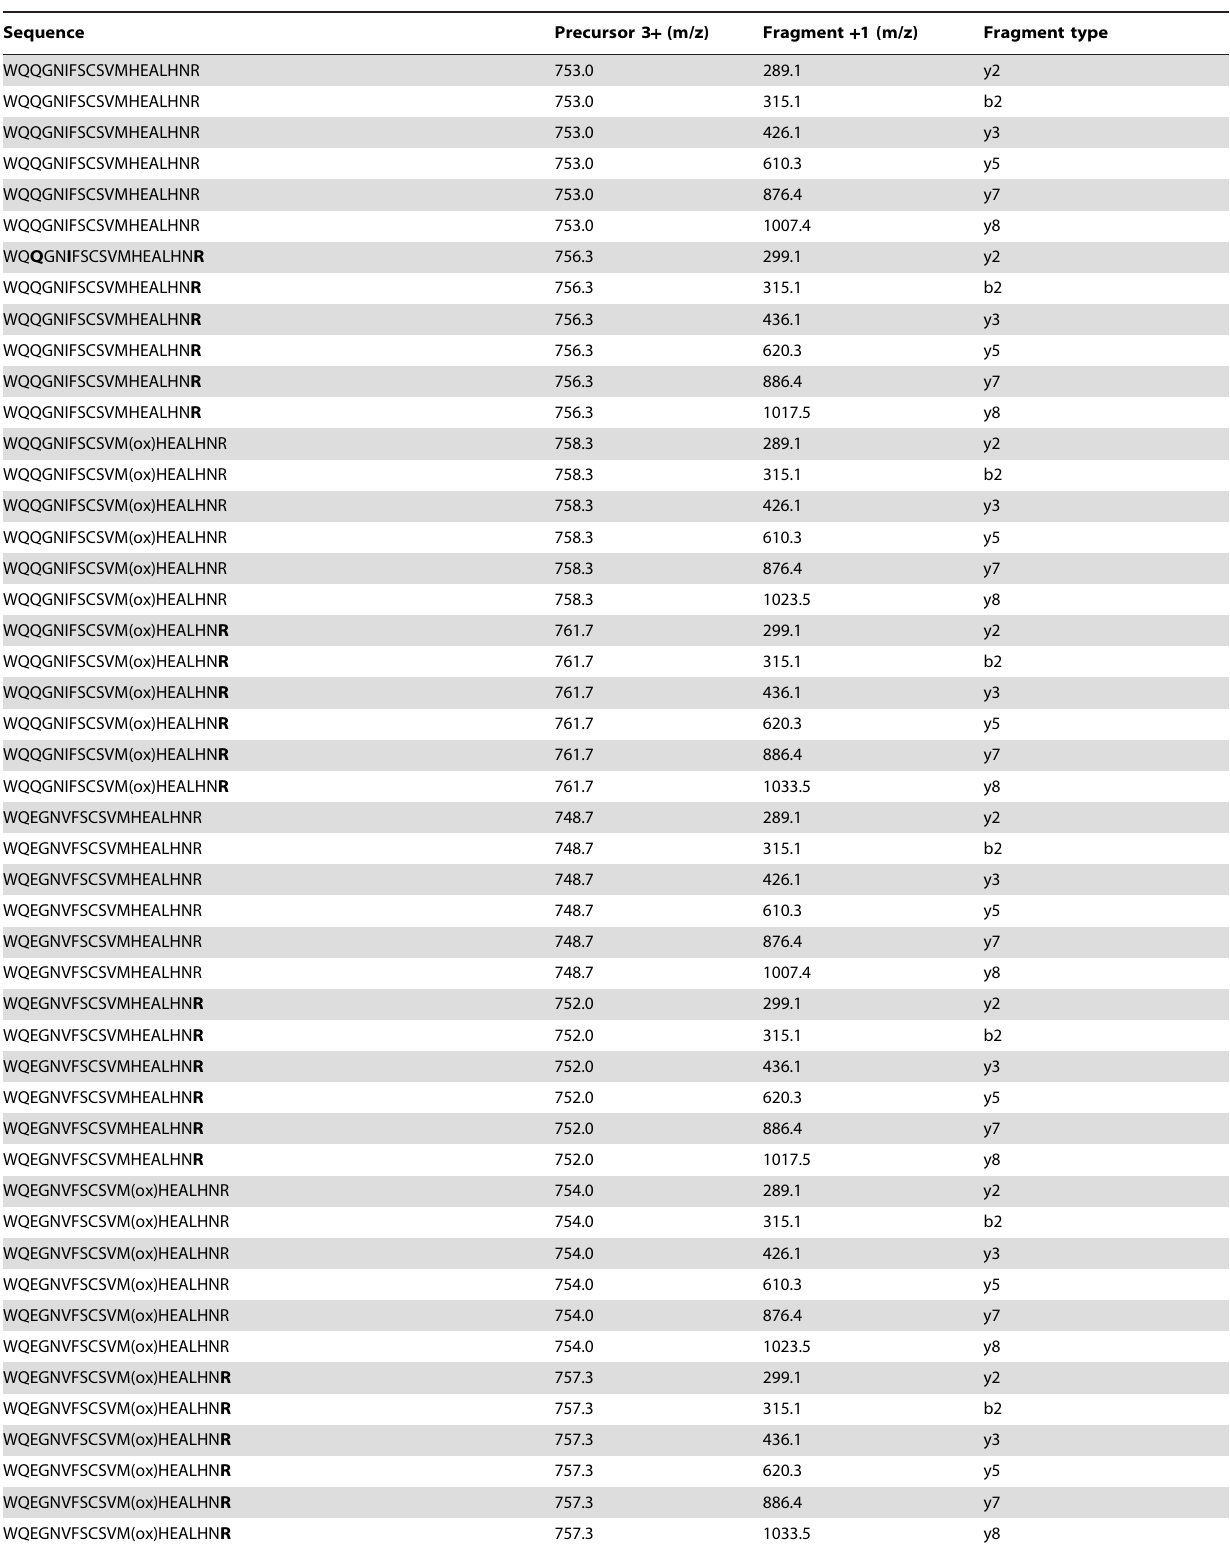
Table 3. Transitions used in SRM experiments for peptides WQQGNIFSCSVMHEALHNR ( # 24, G3m5*)